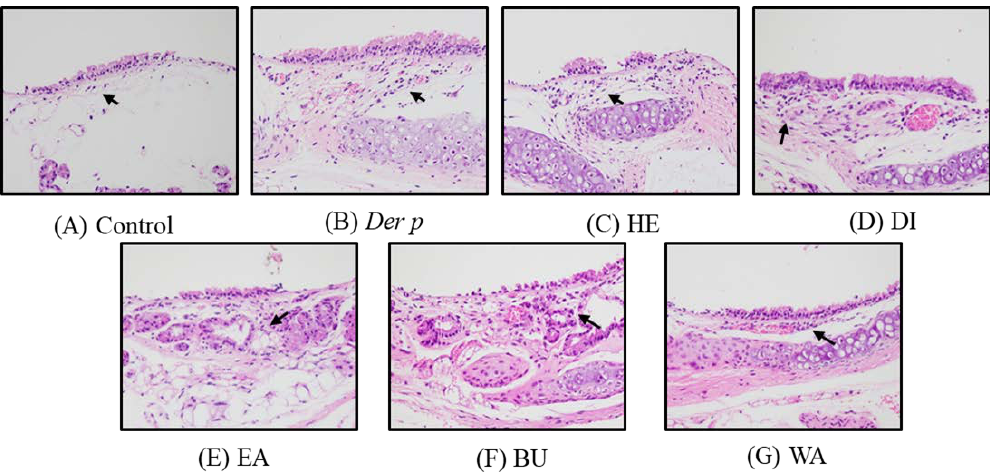
Figure 3. Histopathological findings in the bronchus of mice with Der p–induced allergic asthma. Inflammatory cell infiltration is indicated by black arrows. ( A ) control group; ( B ) Der p group; ( C ) n-hexane fraction group; ( D ) dichloromethane fraction group; ( E ) ethyl acetate fraction group; ( F ) n-butanol fraction group; ( G ) water fraction group. (H&E staining, original magnification 400×).